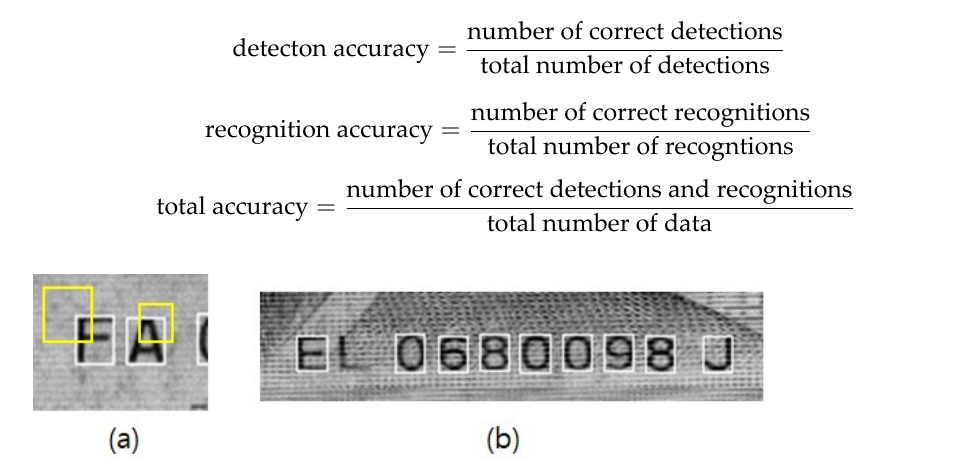
Figure 8. Examples of detection errors (yellow box: prediction; white box: ground truth): ( a ) first case; ( b ) second case.